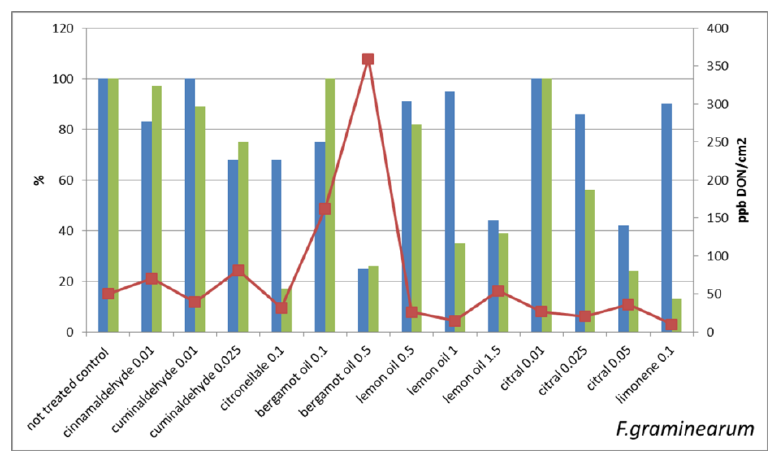
Figure 2. Impact of sub-lethal product concentrations on F. graminearum growth and mycotoxin production. Blue bars indicate the mean values of mycelium in vitro growth (expressed as percentage of growth respect to untreated control) of Fusarium graminearum treated with sub-lethal concentrations of the indicated natural products. Green bars represent the mycotoxin production (expressed as percentage of deoxynivalenol (DON) respect to untreated control) and the line chart indicates the DON concentration (expressed in ppb) per mycelium unit area (expressed in cm 2 ). Figure 2 reports the mycelium growth of Fusarium graminearum (expressed as percentage of growth respect to control) and the DON production (expressed both as percentage of total DON production respect to control and as ppb of DON per mycelium unit area (cm 2 )). The correlation between the reduction of mycelium growth and of total mycotoxin production (r = 0.53) is significant at 0.05 level. In Fusarium langsethiae (Figure 3) the correlation between reduction of mycelium growth and of T-2,HT-2 production is significant at 0.05 level (r = 0.59).